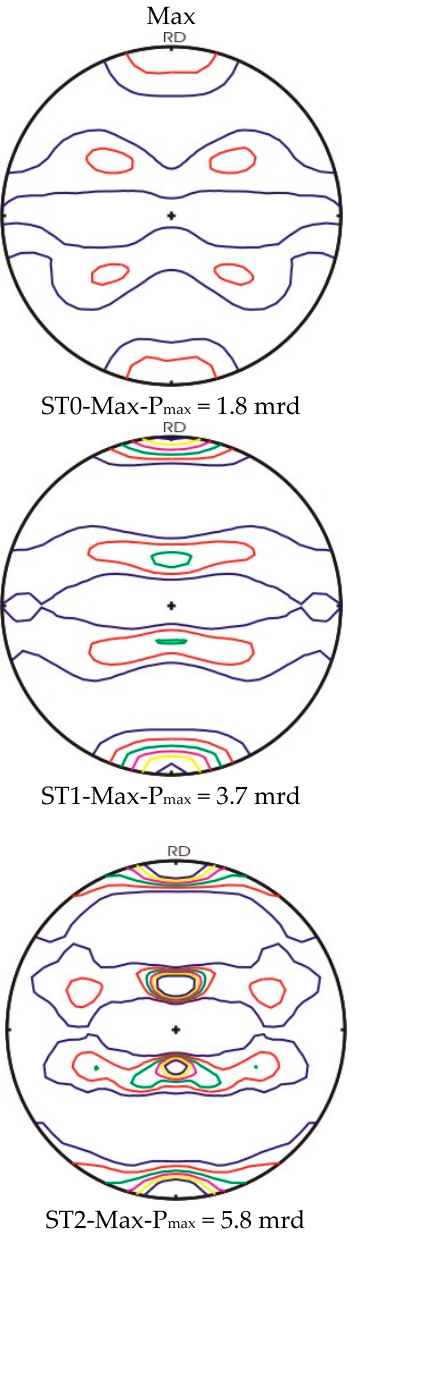
Figure 9. The (111) pole figures of tube 4ST after different passes.